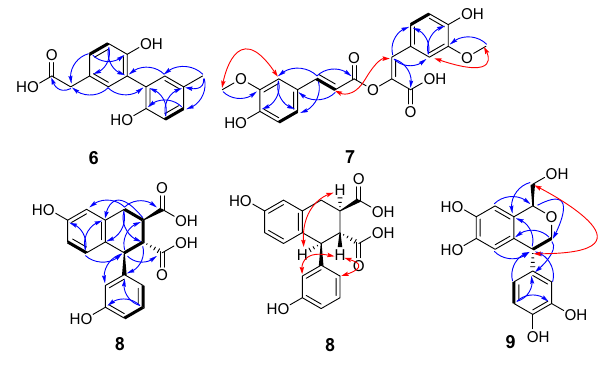
Fig. 4 1 H– 1 H COSY (black bond), Key HMBC (blue arrow),